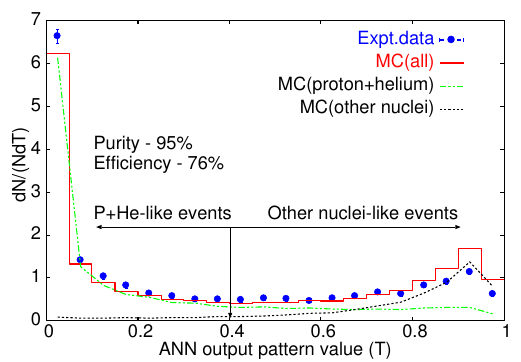
Figure 5. ANN output pattern value (T) distributions compared with MC ( EPOS-LHC + He-poor model ). The average purity and selection e ffi ciency over whole energy range of (P + He) like events are 95%, 76% at T c = 0.4.